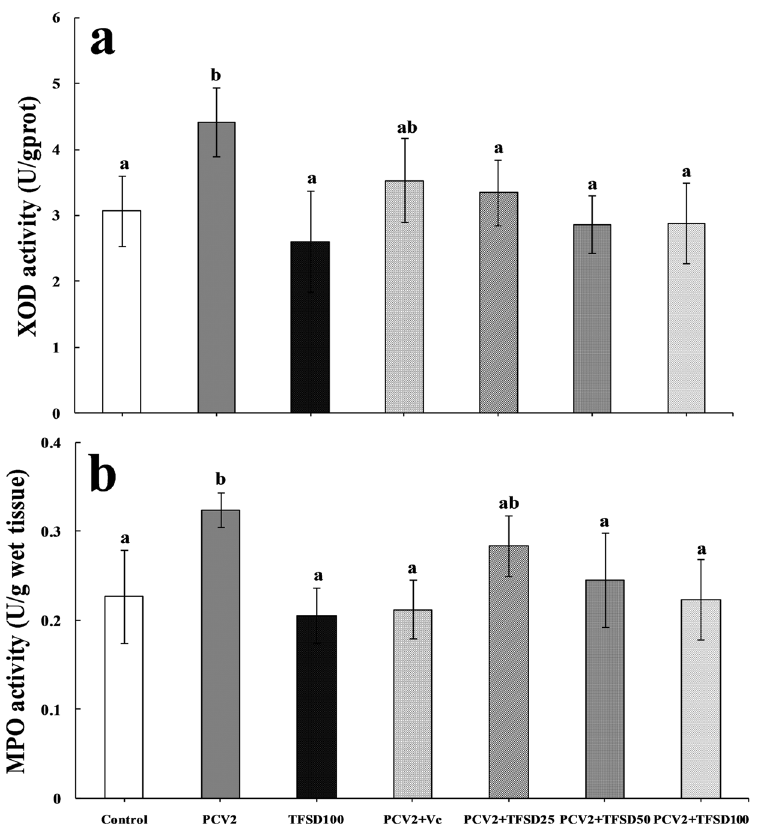
Figure 7. Effect of TFSD on XOD and MPO activities in the spleen of PCV2 infected mice. Data are presented as mean ± SD (n = 10). Bars with different letters are statistically different ( P <